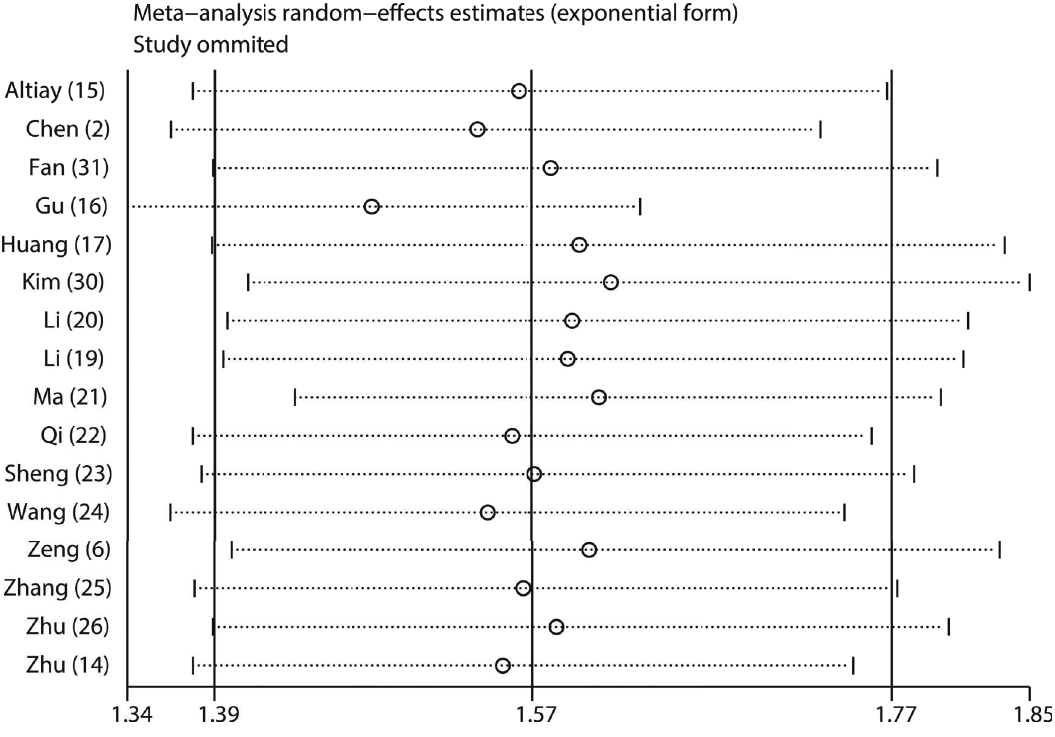
Figure 6 - Subgroup analysis of exploring the possible sources of heterogeneity for the pooled HR for OS.